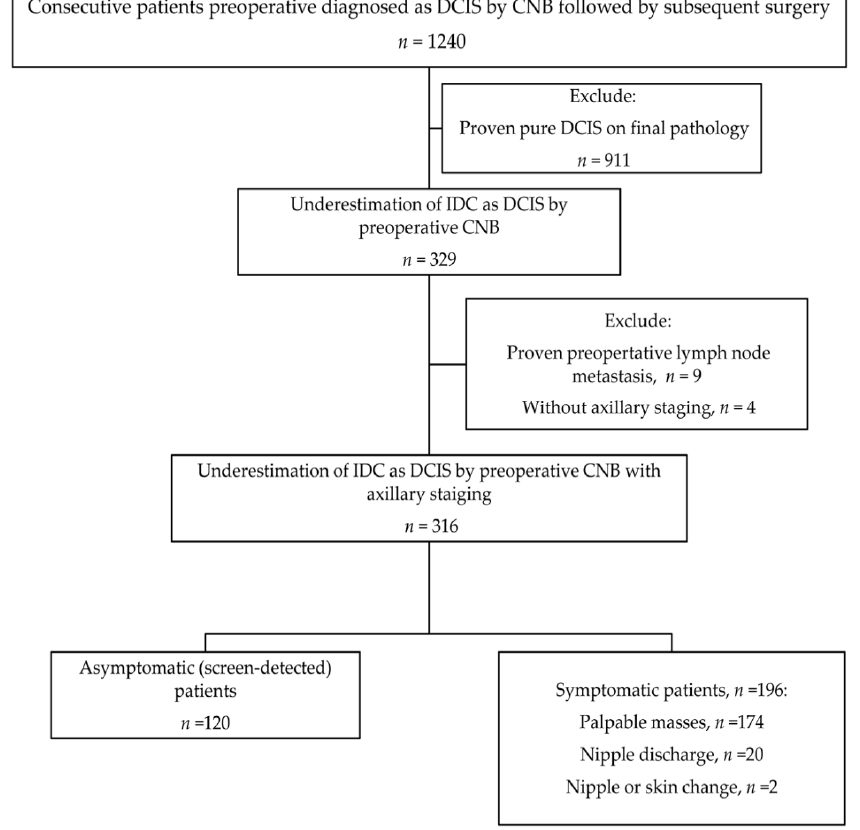
Figure 1. The flow diagram of the study. DCIS, ductal carcinoma in situ; CNB, core needle biopsy; IDC, invasive ductal carcinoma.